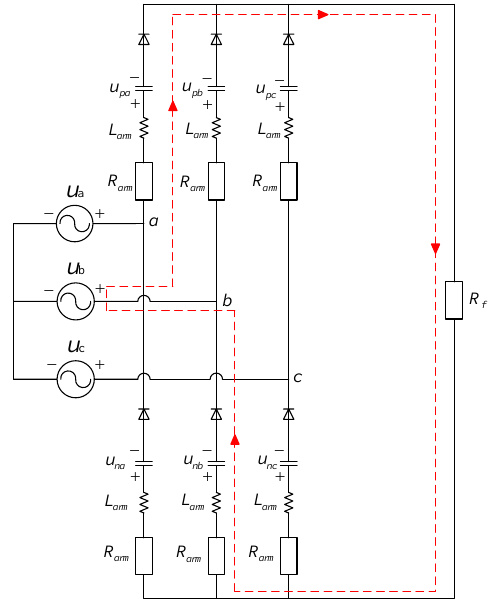
Figure 7. CHBFBSM-MMC equivalent circuit when blocked.